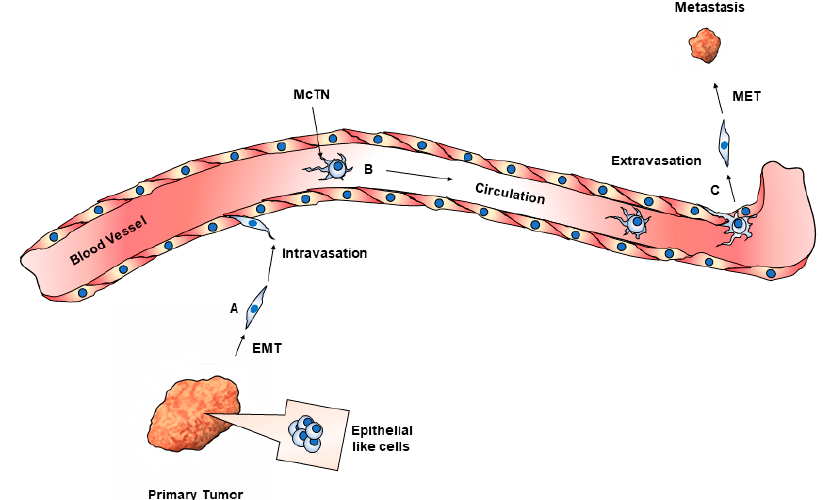
Figure 3. Epithelial to Mesenchymal Transition (EMT) and metastasis. ( A ) Epithelial-like cells in the primary tumor undergo a transition to a mesenchymal phenotype and migrate towards the vasculature. ( B ) Detached tumor cells in the circulatory vessels display microtubule-based structures, termed Microtentacles (McTN). ( C ) McTN aid in reattachment and extravasation. Extravasated cells undergo a mesenchymal to epithelial transition, and seed tumors at distal sites.